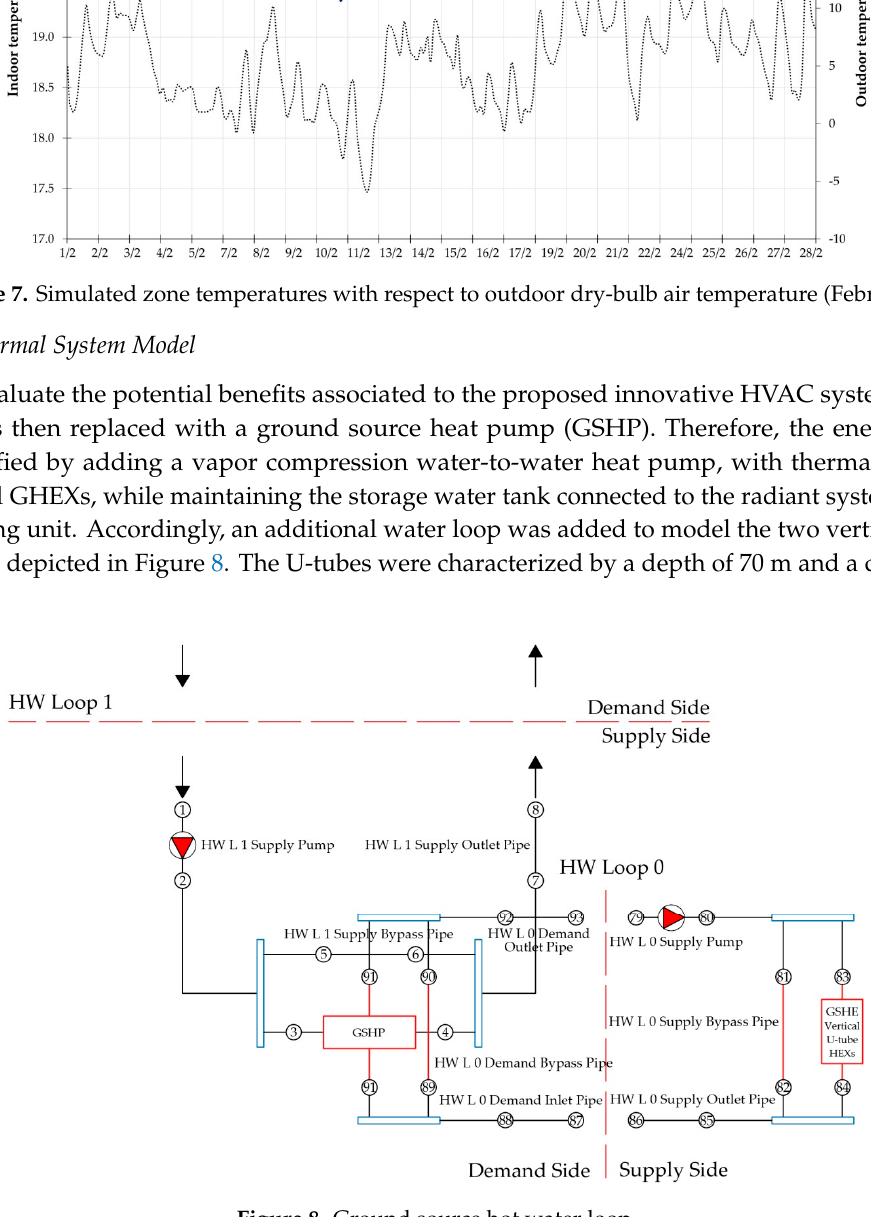
Figure 8. Ground source hot water loop.